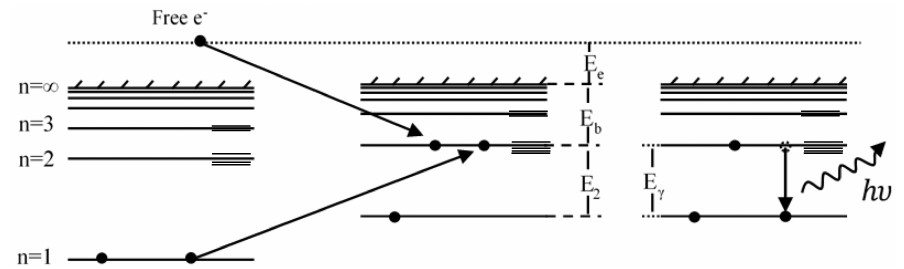
Figure 1. The DR process has a resonant nature, which arises from energy matching between the incoming free electron (E 1 e ) and the binding energy of the level it is captured to (E 1 b ) with the excitation energy (E 2 ) of the second electron [11]. Reproduced with permission from Gall, Amy Christina, Inner Shell Atomic Processes in Highly Charged Argon EBIT Plasma Relevant to Astrophysics; published by Clemson University TigerPrints All Dissertations,